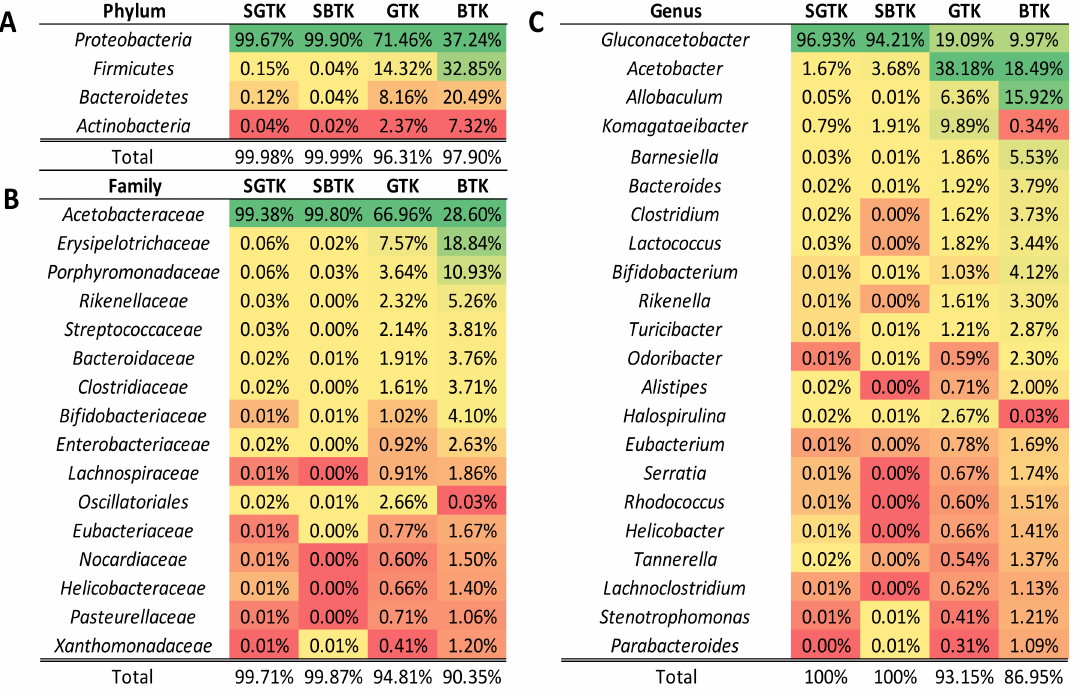
Figure 3. Heat map based on the relative abundance (>1.0% in at least one sample) of the most abundant bacterial taxa of phylum ( A ), family ( B ), and genus ( C ) identified in green tea kombucha (GTK), black tea kombucha (BTK), and their respective SCOBY (SGTK and SBTK). Green to red gradient indicates low to high relative levels of OTUs within the given taxonomic